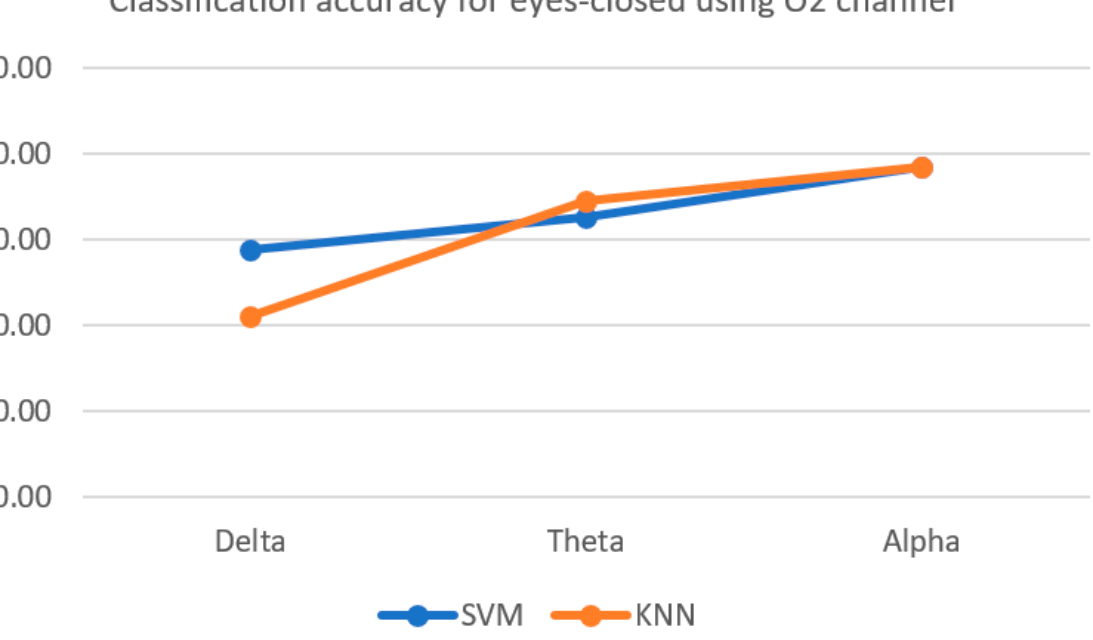
Figure 4. Classification accuracy using O2 channel during EC for delta, theta, and alpha wave bands.